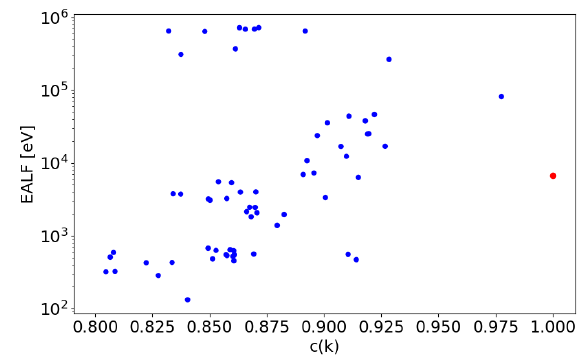
Figure 1d. Updated EALF for the relevant experiments and Case 1.